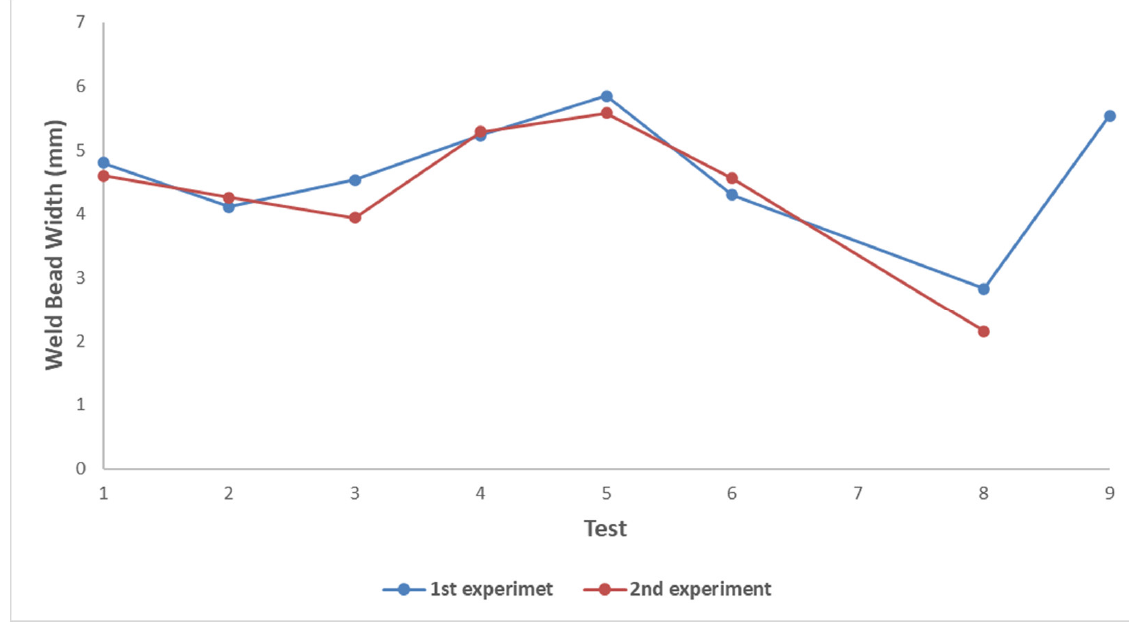
Figure 8. Graphic representation of the average values obtained for the width of the weld bead in experiments 1 and 2. After acquiring and organizing the results, the Taguchi method was applied. As